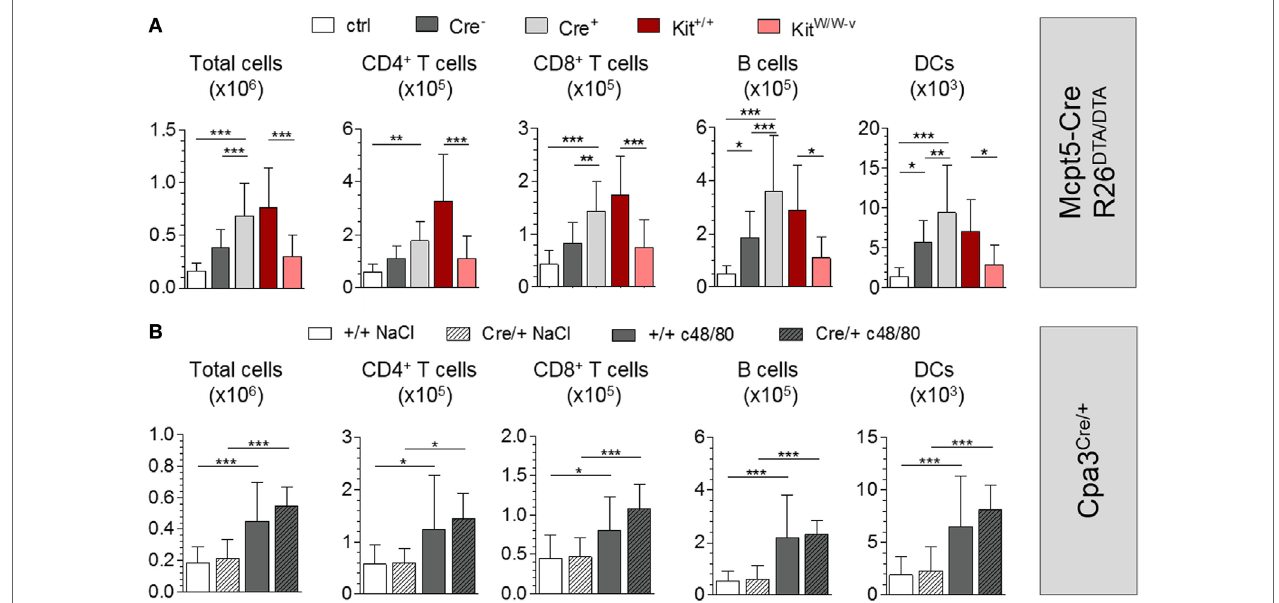
FigUre 4 | Mast cells (MCs) are not required for c48/80-mediated LN hypertrophy. (a) Cellularity of popliteal LNs 24 h after injection of c48/80 into footpads of Mcpt5-Cre + R26 DTA/DTA and Cre -negative littermate control mice ( n = 11 both groups) as well as Kit W/W–v ( n = 5) and congenic Kit + / + control animals ( n = 7) as determined by flow cytometry. Saline injected Cre -negative mice ( n = 6) served as controls. Data from two independent experiments with similar results. (B) Cellularity of popliteal LNs 24 h after injection of c48/80 into footpads of Cpa3 Cre/ + and Cpa3 + / + littermate control mice ( Cpa3 + / + n = 16, Cpa3 Cre/ + n = 11) as determined by flow cytometry. Saline was injected as control into one of both paws. A single experiment was performed. In all cases, means ± SD are shown and statistical analysis was performed using one-way ANOVA and Bonferroni’s multiple comparison